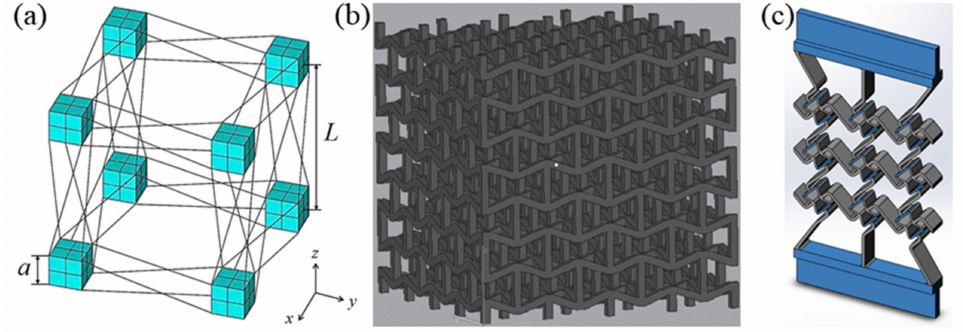
Figure 16. 3D chiral lattice structure: ( a ) stretch-twist coupling lattice [21], ( b ) 3D re-entrant lattice [21], and ( c ) re-entrant core cell